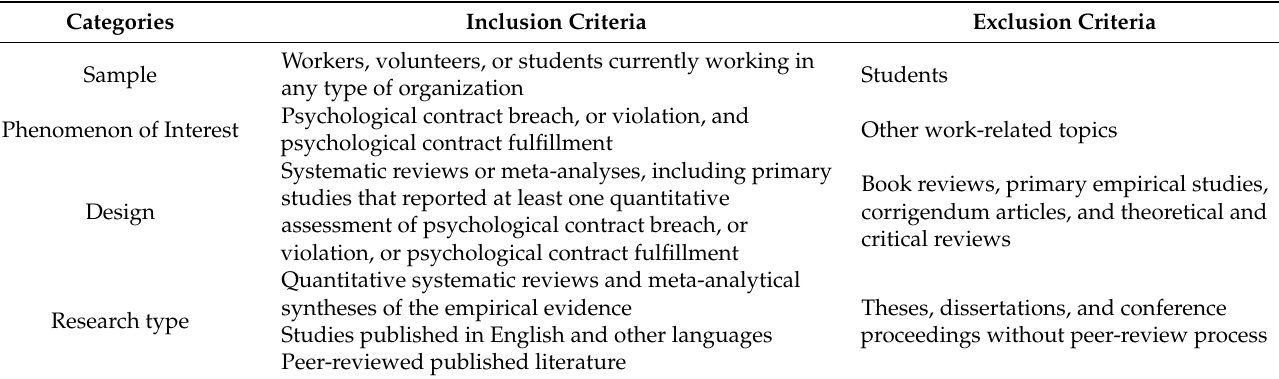
Table 1. Inclusion and exclusion